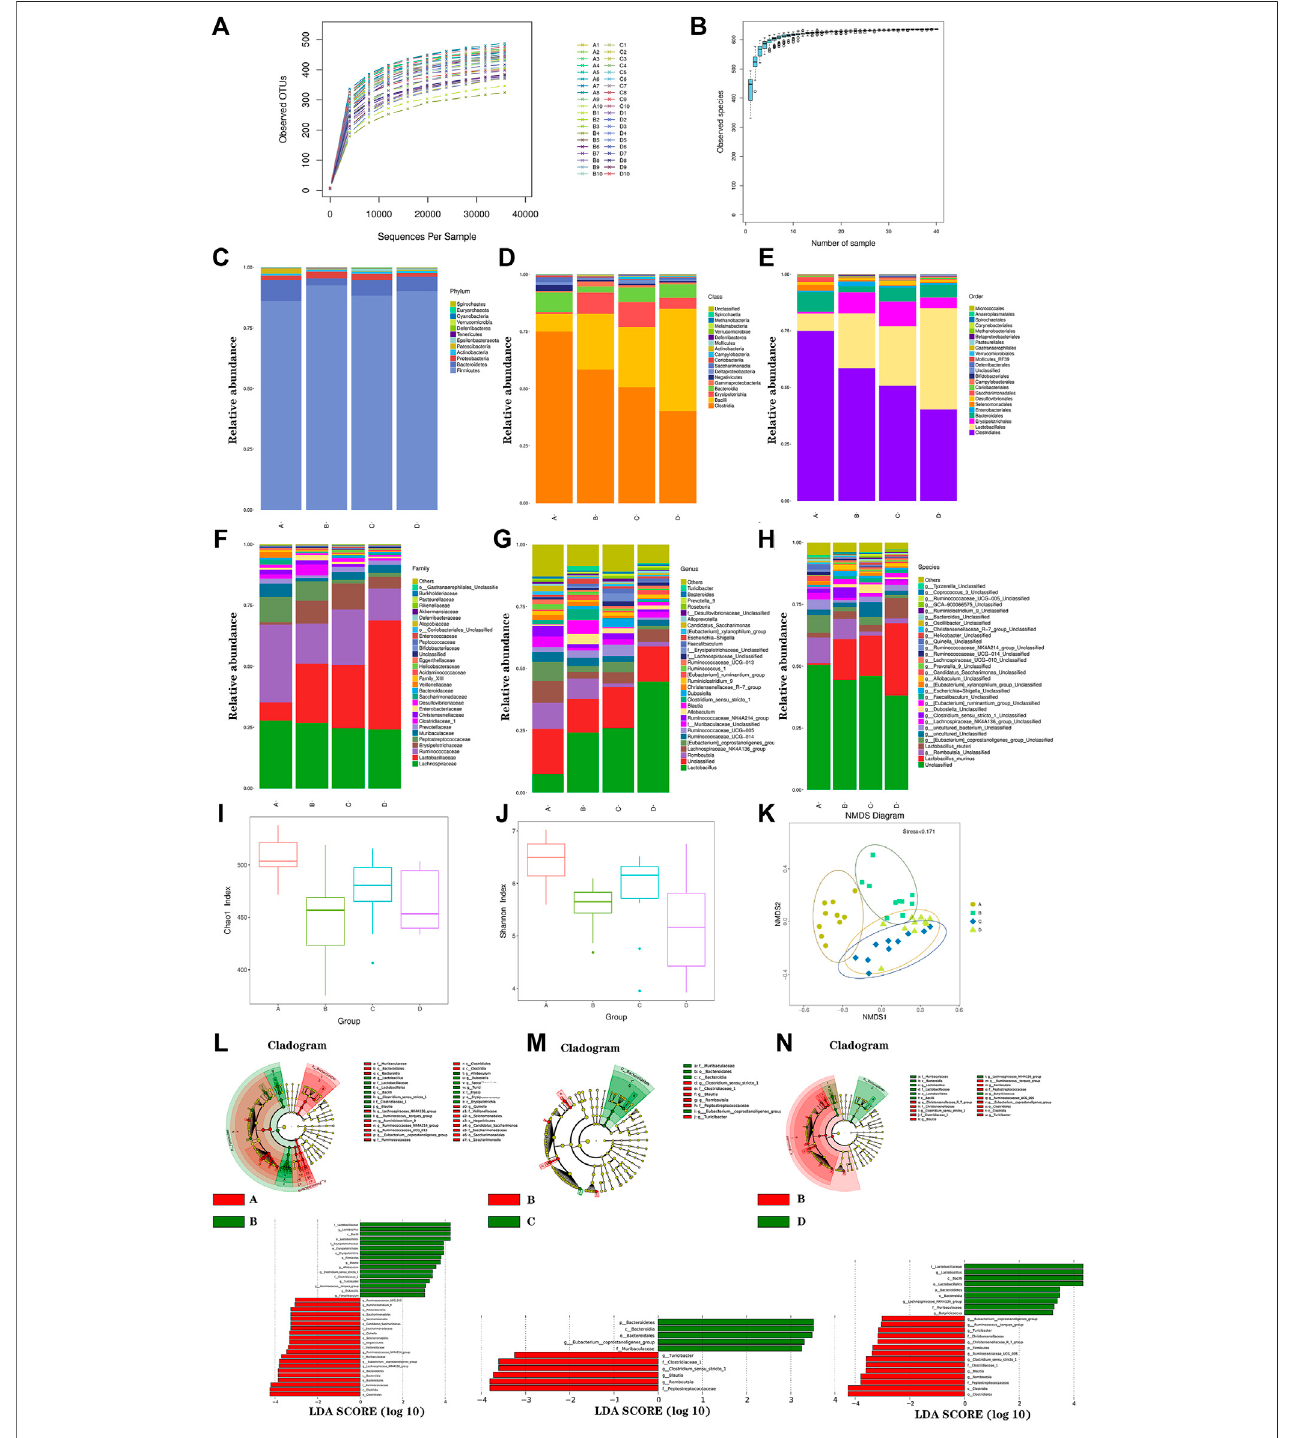
FIGURE4| Gutmicrobiotaanalysis.Therarefactioncurve (A) ;speciesaccumulationcurve (B) ;histogramofspeciesdistributionatdifferentlevels (C) ;phylum; (D) , class; (E) , order; (F) , family; (G) , genus; (H) , species;Chao1 index (I) , Shannon index (J) , NMDS analysis (K) , LEfSE diagram ofcharacteristic ingut microbiota between groups (L – N) . A, normal group; B, model group; C, low-dosage group; D, high-dosage group.